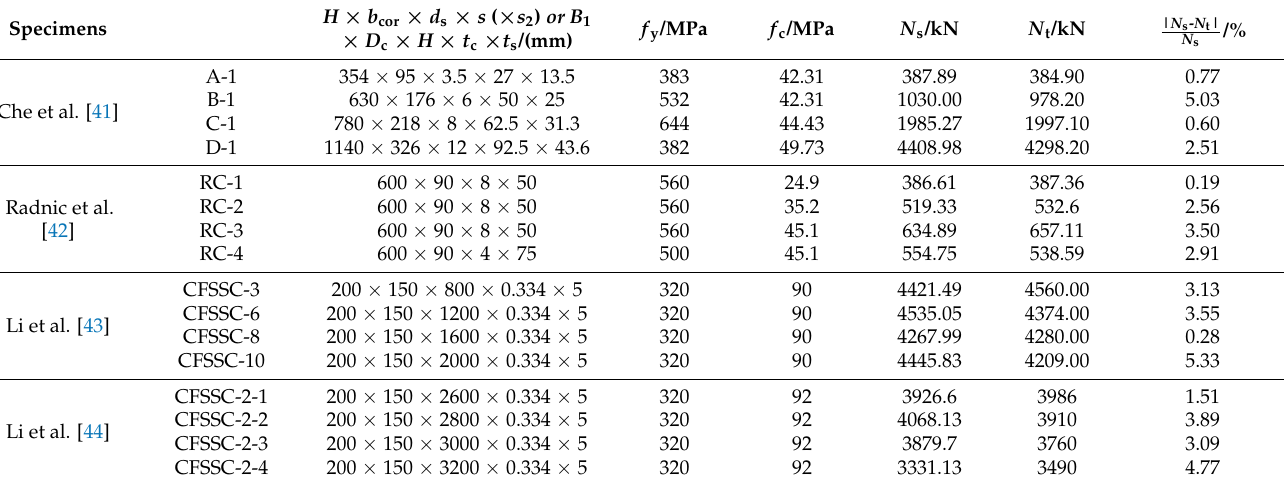
Table 4. The comparison of the bearing capacity under axial compression between the simulation and experiment for sixteen specimens.